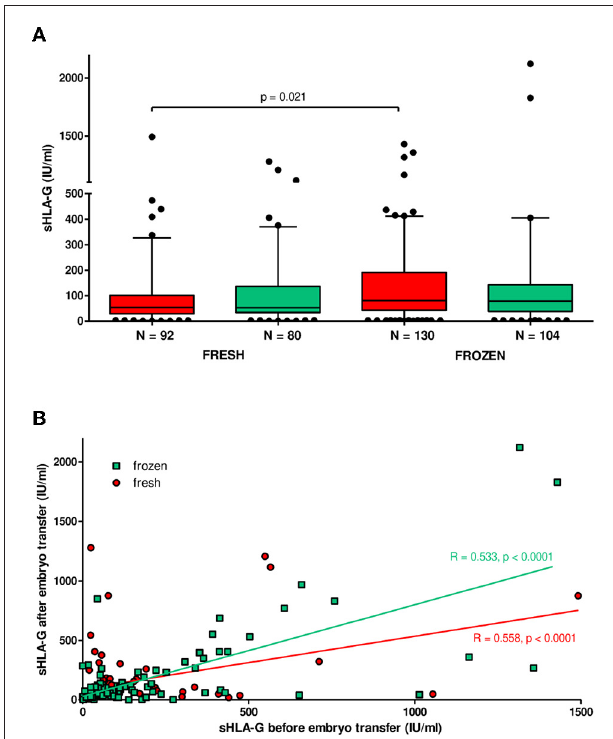
FIGURE 6 | Soluble HLA-G plasma level in patients undergoing fresh or frozen/thawed cycles. (A) Median concentration of sHLA-G (black lines in boxes). Boxes are drawn from the first quartile (25th percentile) to the third quartile (75th percentile). Whiskers represent 10–90 percentiles. N is the number of patients. sHLA-G was measured in plasma of patients before (red boxes) and after embryo transfer (green boxes). p -value is calculated by Mann–Whitney test. (B) Correlation analysis obtained with Spearman correlation test. On the x and y axes are values for sHLA-G (IU/ml) before and after embryo transfer. Frozen cycle is represented by green line and fresh by red line ( R , Spearman correlation coefficient; p , p -value).